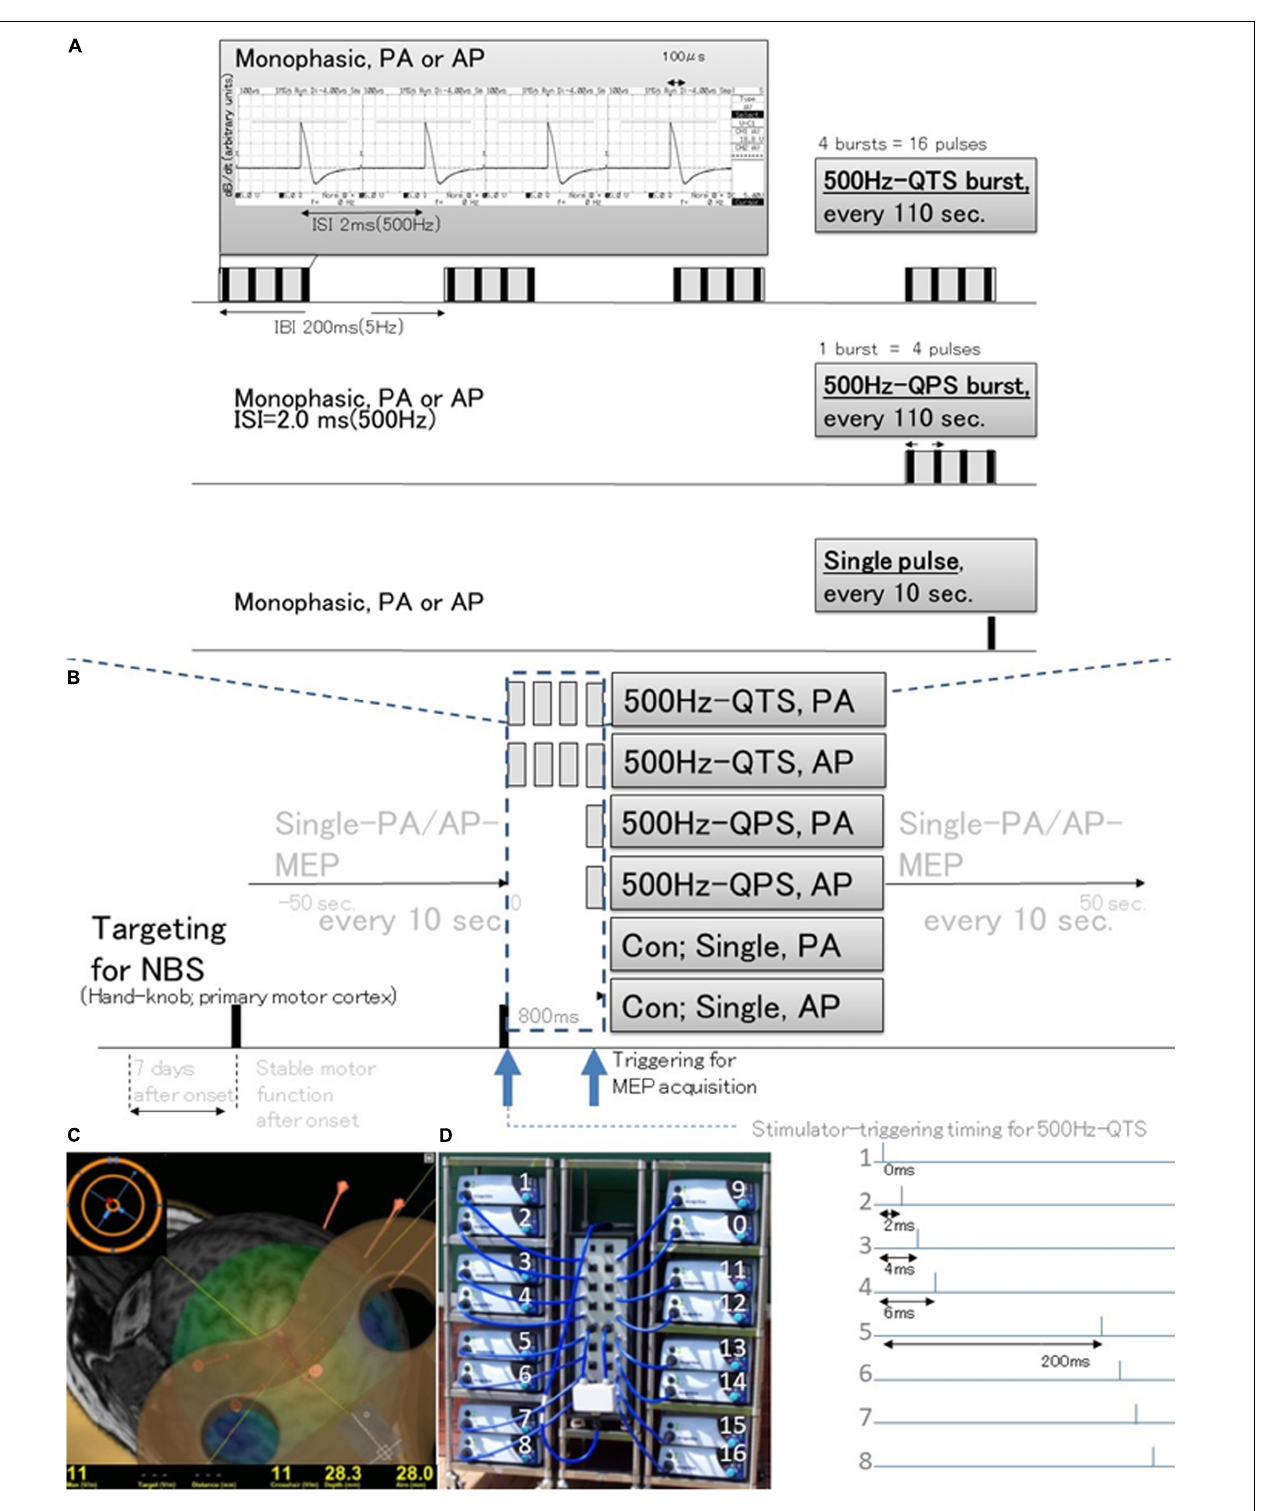
FIGURE 1 | Schematic illustration of the experimental protocol and stimulus configurations. Comparison between standard single-pulse magnetic stimulation induced-MEPs, single 500-Hz burst and four 500-Hz bursts, repeated at 5-Hz stimulation MEPs (different induced current frequencies, current flow configuration in the motor cortex, and polarity; monophasic PA and AP directions in each modality). (A) Stimulus conditions: 500-Hz quadripulse theta burst stimulation (QTS), 500-Hz quadripulse single train stimulation (QPS), and monophasic single pulse. PA and AP polarity in each modality were compared. QTS consisted of four